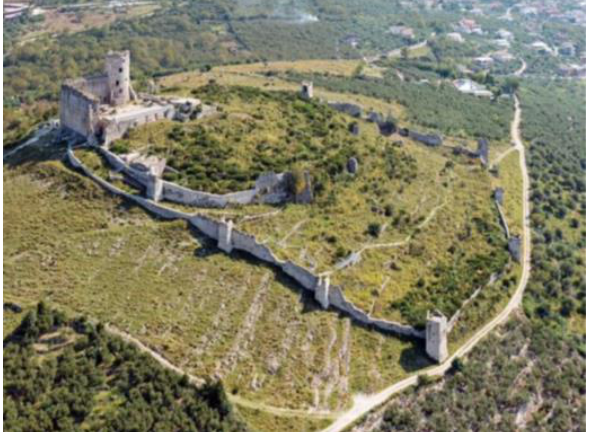
Figure 1: View of the castle of